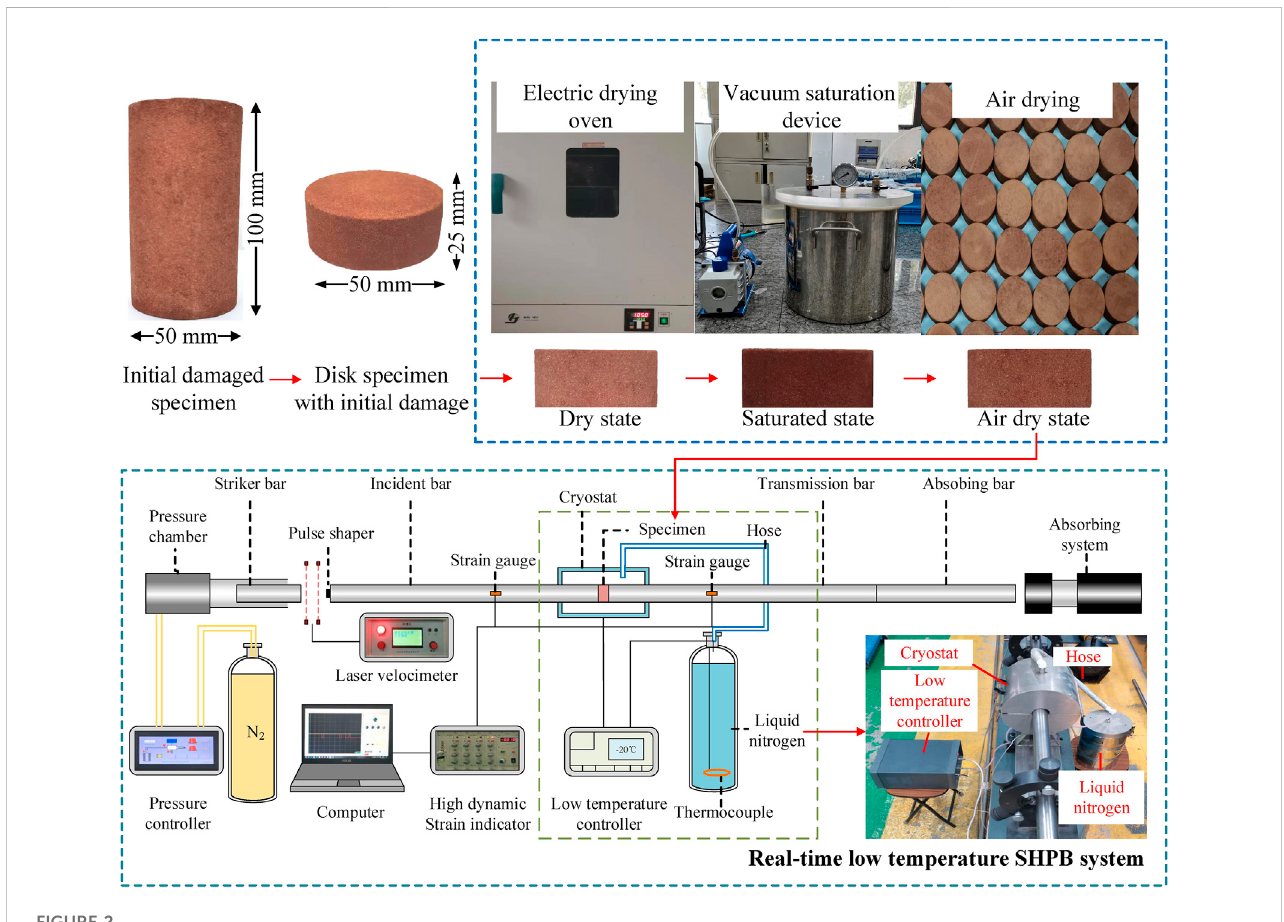
FIGURE 2 Process of real-time low temperature SHPB